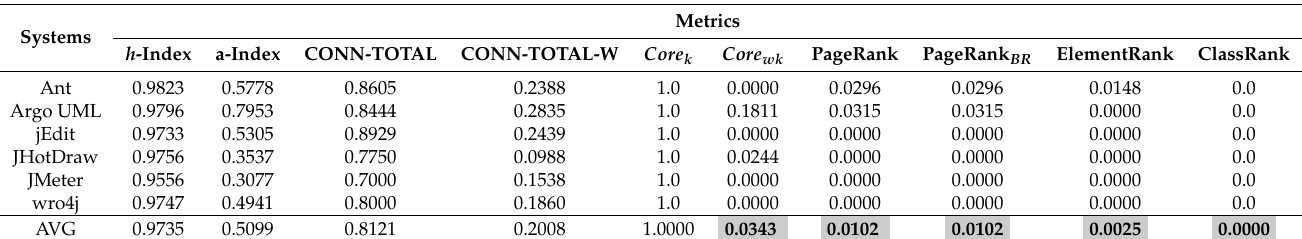
Table 2. The results of the repetition rate. The cells highlighted in gray background denote the values lower than 0.05 and the corresponding metrics that are left.